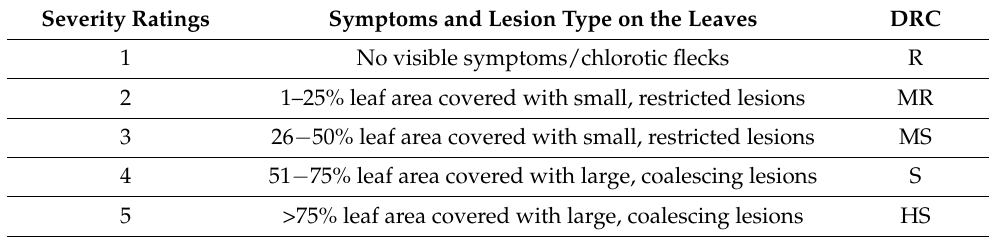
Table 2. Assessment scale of anthracnose disease against sorghum plants under field conditions. Severity